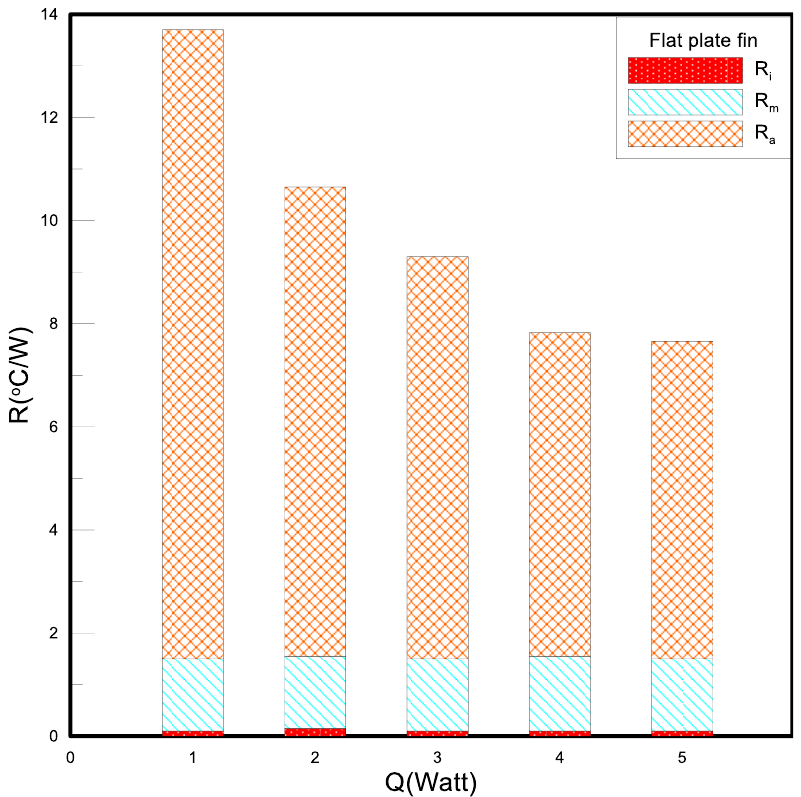
Figure 14. Thermal resistances of nature convection.